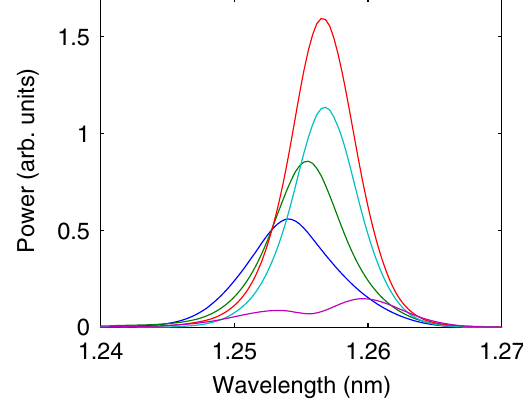
FIG. 13. Selection of FEL pulse spectra at 17.7 m calculated using different shot-noise seeds.